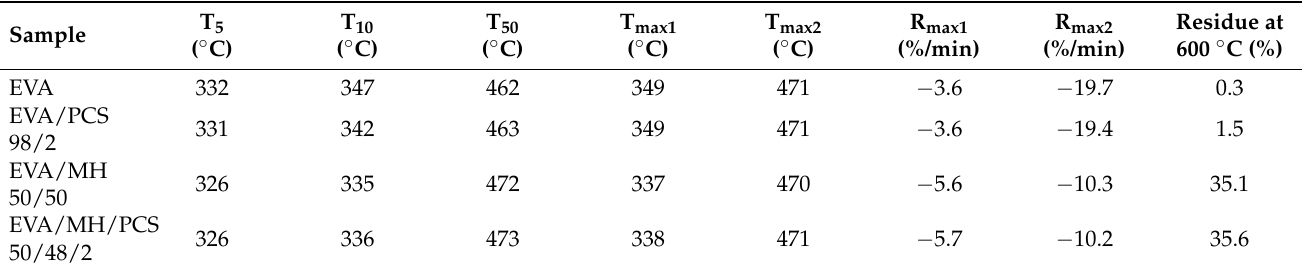
Table 2. The TG and DTG parameters of EVA and its composites.